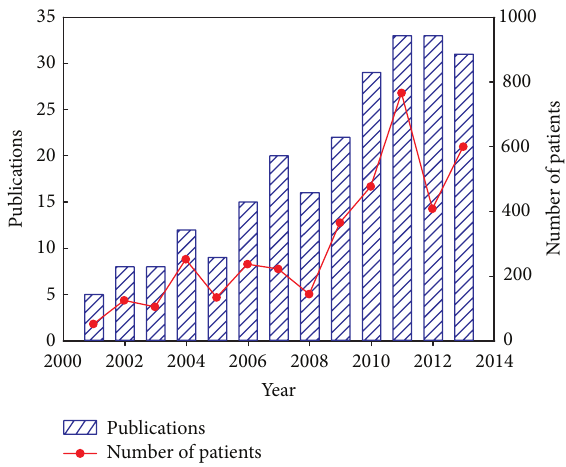
Figure 1: The number of publications and advanced pancreatic can- cerpatientstreatedwithHIFUorinconjunctionwithchemotherapy or radiotherapy from 2001 to